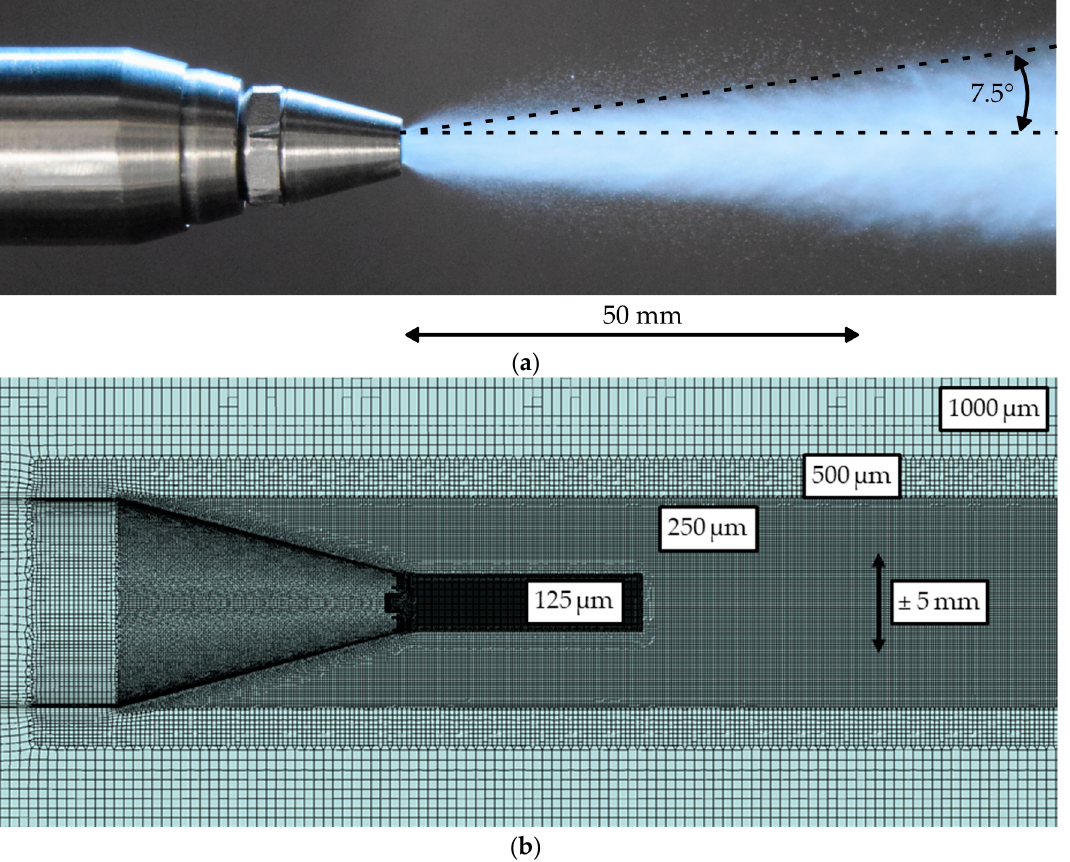
Figure 3. ( a ) Spray image of the near nozzle area taken from the experiment. ( b ) Local mesh refinements of the computational mesh in the near nozzle area with corresponding cell sizes and identification of the radial range of the first measurement